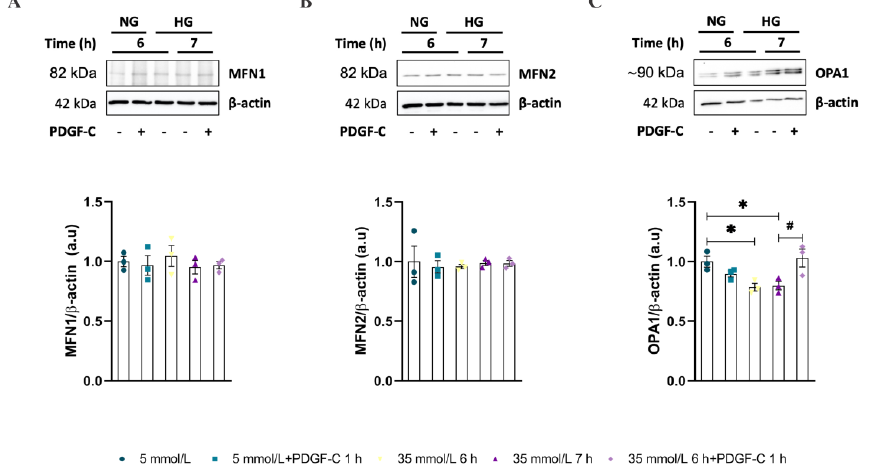
Figure 2. Effect of PDGF-C on fusion-related proteins in HAECs exposed to high glucose. Cells were seeded in 6 well plates and exposed to HG (35 mmol/L d-glucose) for 6 and 7 h, treated or not with 50 ng/mL PDGF-C for 1 h, and ( A ) MFN1, ( B ) MFN2, and ( C ) OPA1 expression was evaluated by western blot. Images correspond to representative blots for each protein. Densitometry analysis corresponds to the band of each protein normalized with the band of β -actin. Data represent the mean ± SEM of at least three independent experiments (* p < 0.05, # p < 0.05 regarding HG).